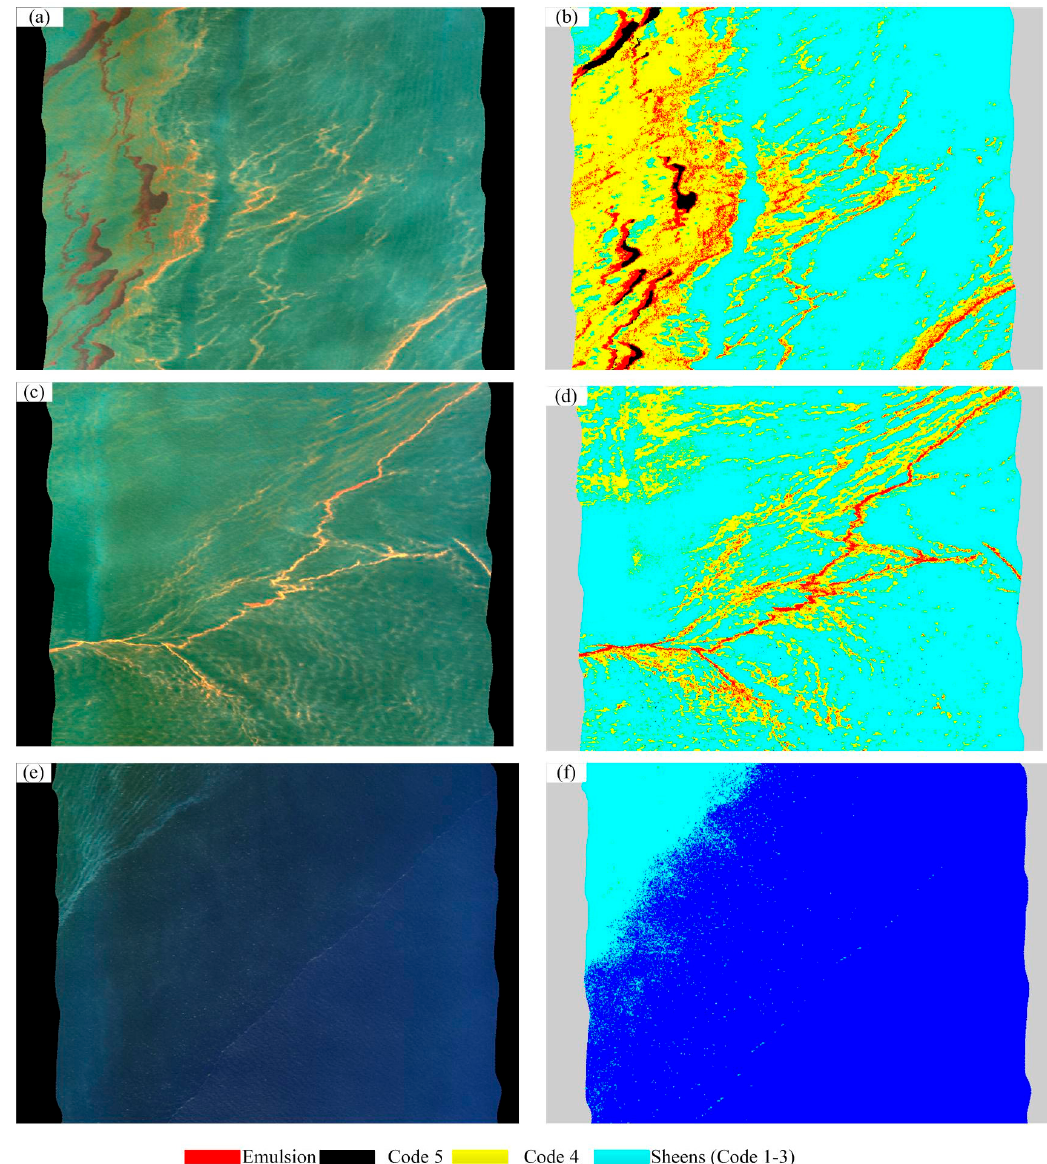
Figure 18. Three test areas used to validate the complementarity of spectral indices of hydrocarbons and seawater. Pictures ( a , c , e ) are the false-color composited test images ( a , b , c ), respectively. Pictures ( b , d , f ) are the identification results of test images ( a , b , c ), respectively.